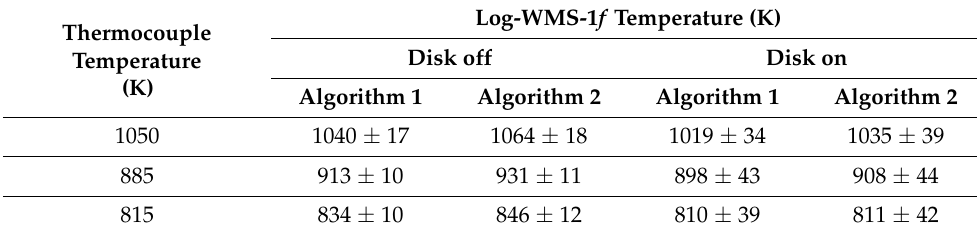
Figure 8. The results of temperature evaluation by the log-WMS-1 f technique in each of the 18 scans. The dotted black trace is the reading of the thermocouple. Plots with symbols are inferred temperature from log-WMS-1 f single scans: solid black plot—disk off, fitting by algorithm 1; green plot—disk off, algorithm 2; red plot—disk on, algorithm 1; blue plot—disk on, algorithm 2. Table 2. Results of temperature evaluation by the log-WMS-1 f technique.